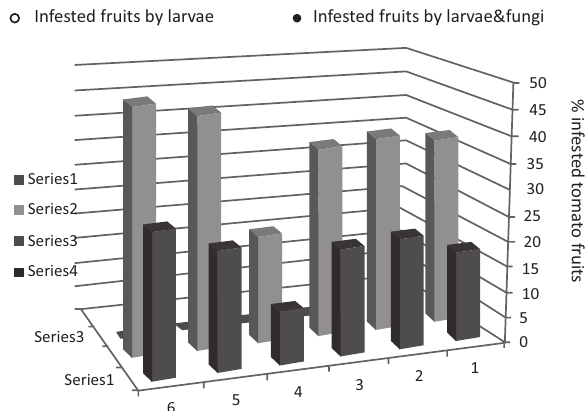
Fig. (2): The percentages of infested tomato fruits by T. absoluta larvae and T. absoluta larvae and fungi in the tested treatments